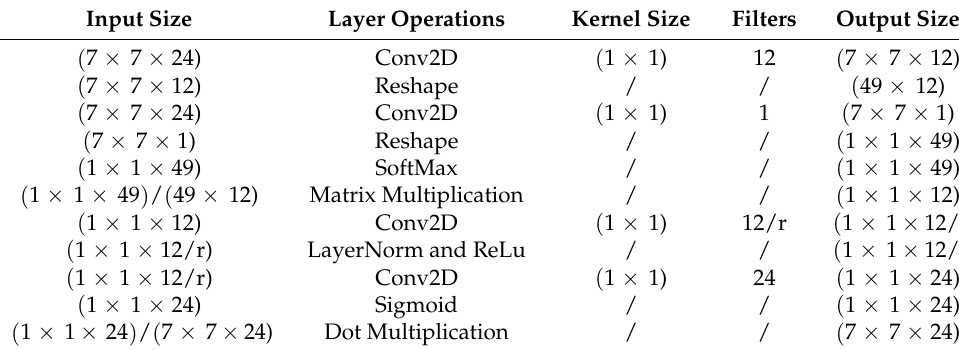
Table 3. Detailed steps of the channel-only polarized attention block.